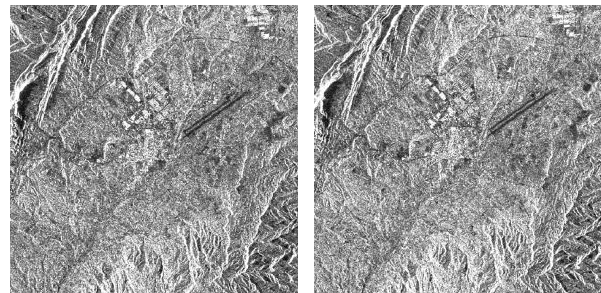
Figure 2. Sentinel-1 stereo images of JAM-Bushehr-Iran